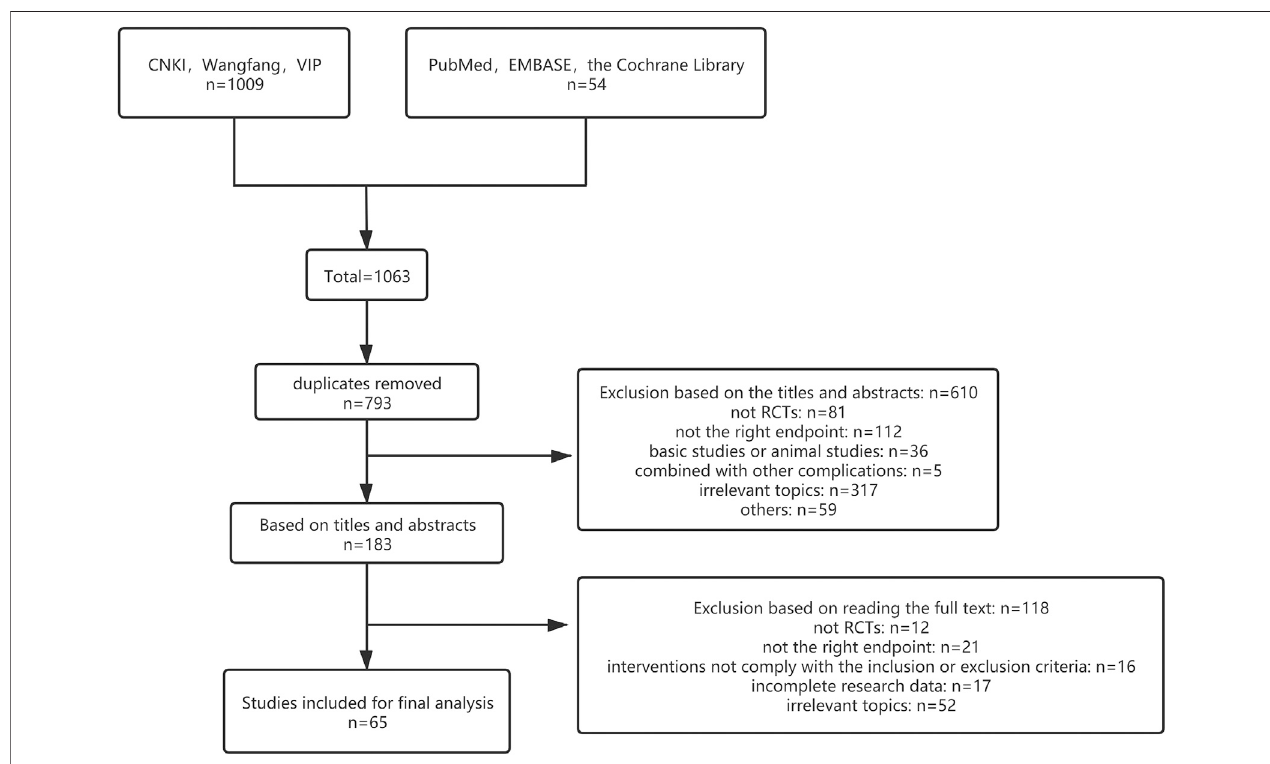
FIGURE 1 | Flow diagraph of study